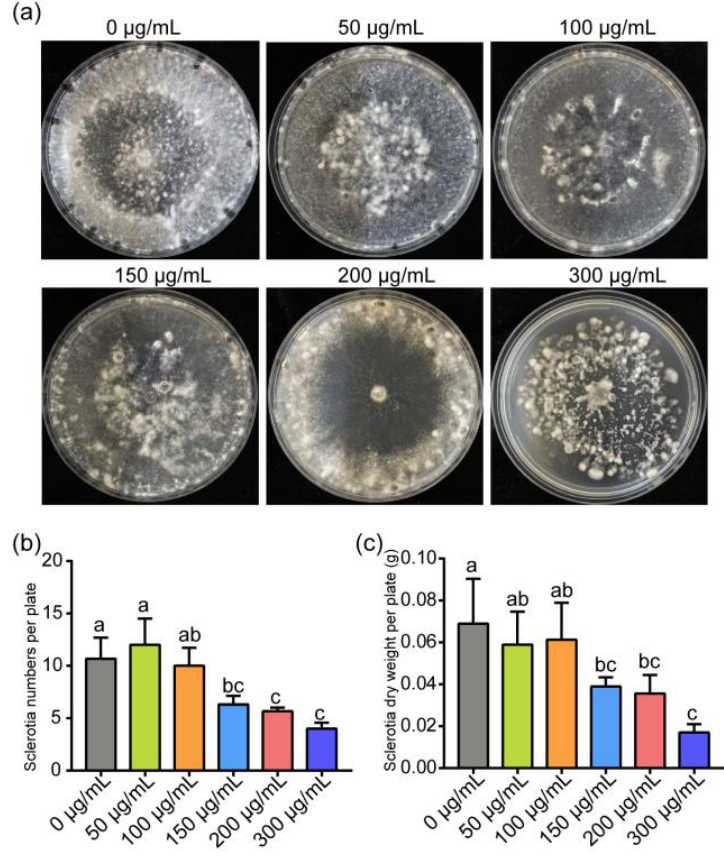
Figure 2. Effects of 0, 50, 100, 150, 200 and 300 µ g/mL ε -PL treatment on the number, morphology and dry weight of sclerotia produced by Sclerotinia sclerotiorum at 9 dpi. ( a ) ε -PL treatment higher than 150 µ g/mL affected the formation and morphology of sclerotia. ( b ) Effect of different concentrations of ε -PL on the number of sclerotia. ( c ) Effect of different concentrations of ε -PL on the dry weight of sclerotia. Different letters indicate significant differences ( p < 0.05).